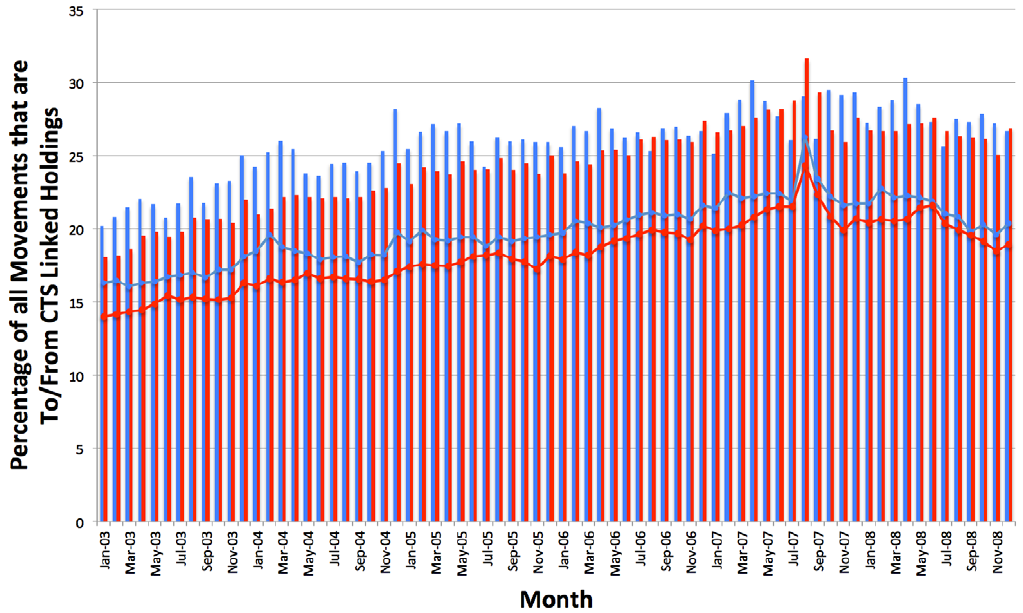
Figure 6. Movements to and from CTS Linked Holdings represented as a percentage of total movements. This chart shows the monthly movements on CTS that come From (red bars) and go To (blue bars) CTS Linked holdings, represented as a percentage of total movements from and to all holdings over time. For the ‘From’ category, only normal and inferred off movements from agricultural holdings in the VLA_MOVEMENTS table of CTS were considered, whilst for the ‘To’ category, only normal and inferred on movements to agricultural holdings were considered. The blue and red lines represent the percentage of holdings that have a From (blue) or To (red) movement that month and are in a CTS Link.